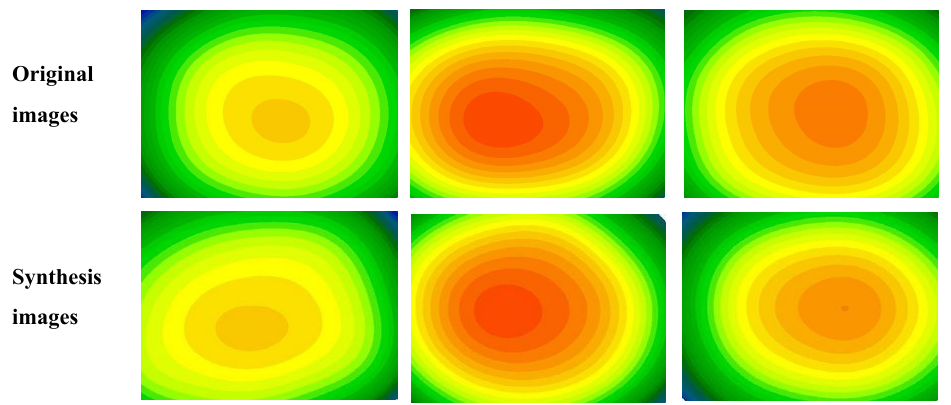
Figure 4. Example of original and synthesis images.